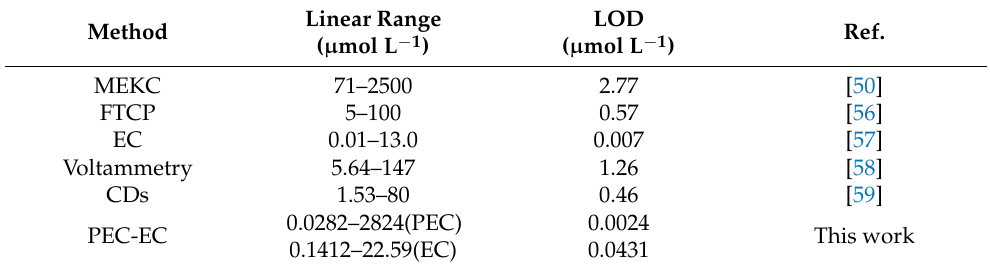
Table 1. Comparison of the different approaches for determining CGA.